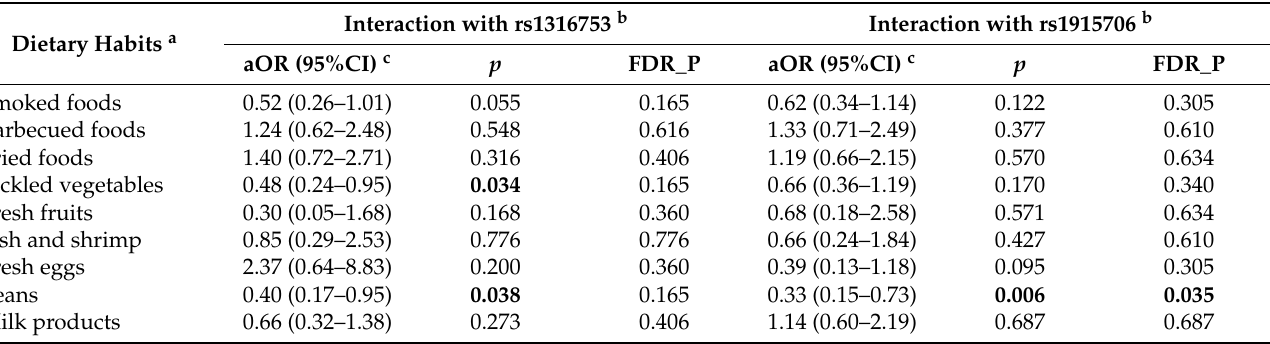
Figure 2. The level of association between genetic variants of BHMT gene, maternal dietary intake and VSD in offspring. Table 5. Interactions of polymorphisms of BHMT gene and maternal dietary habits based on multi- variate logistic regression.